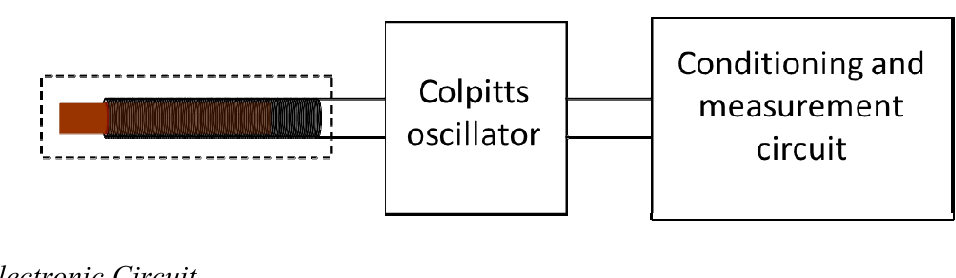
Figure 1. Block diagram of the